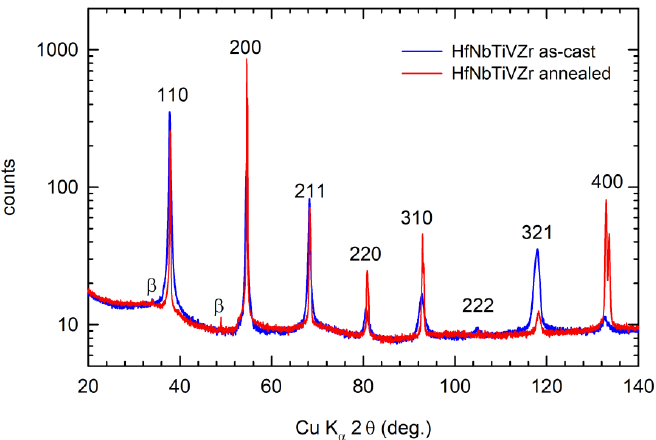
Figure 14. XRD pattern of HfNbTiVZr alloy in the as-cast state and after annealing at 1200 °C. The label β denotes reflection arising from the Cu K β wavelength.